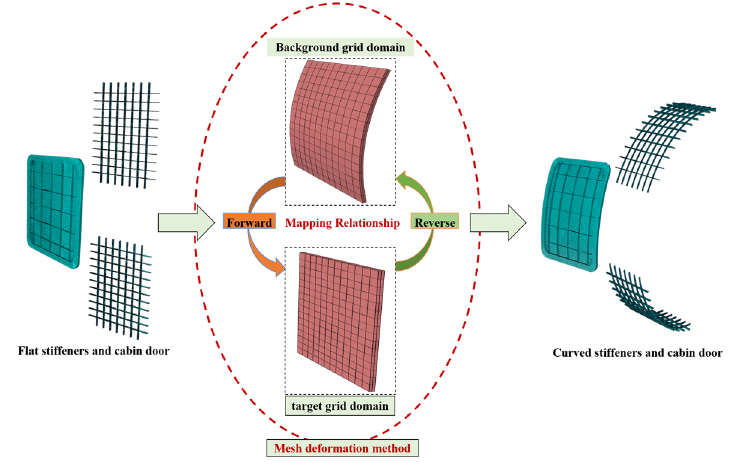
Figure 5. Schematic diagram for modeling of stiffeners and curved cabin door by mesh deformation